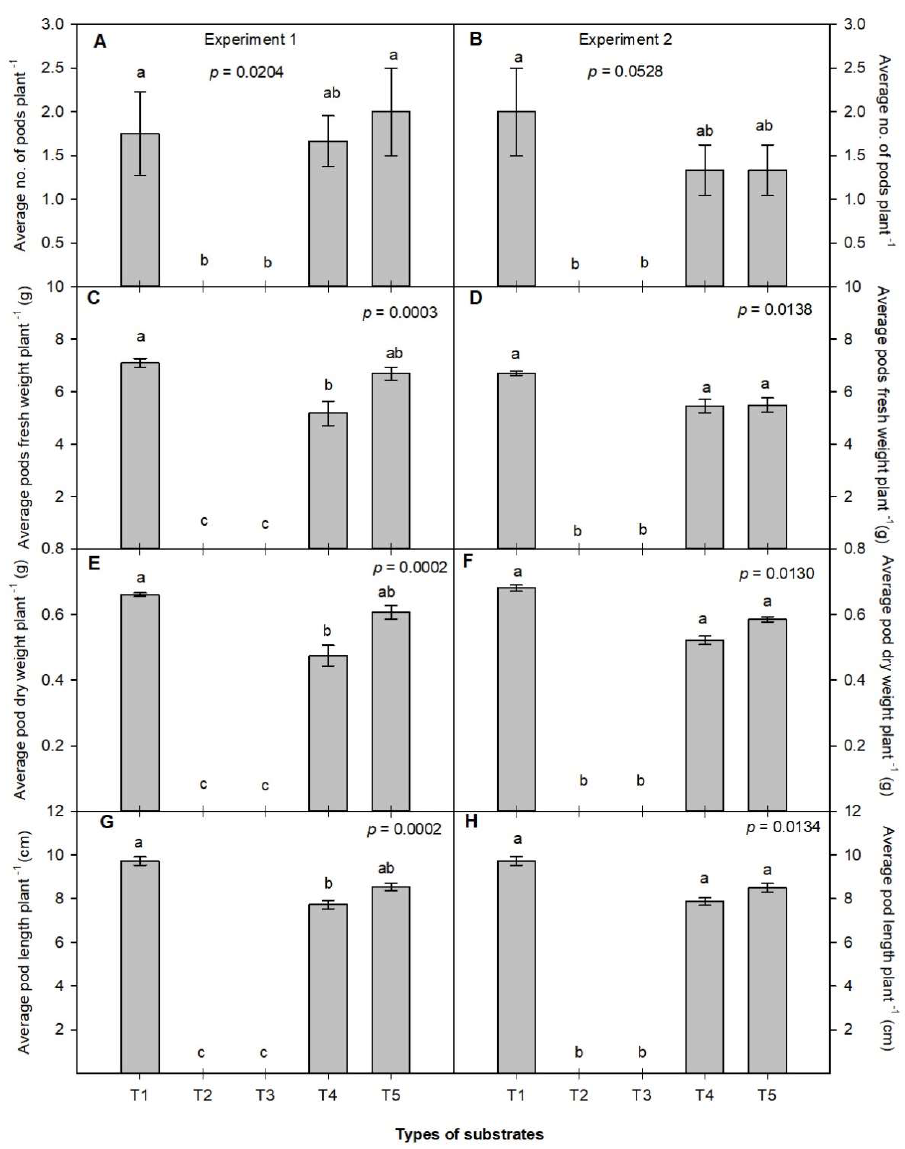
Figure 5. Effect of non-composted Bombax ceiba (Red cotton tree) sawdust mixtures on Abelmoschus esculentus L. (okra). The average number of pods plant −1 ( A , B ), average pods fresh weight plant −1 ( C , D ), average pods dry weight plant −1 ( E , F ), and average pods length plant −1 ( G , H ) in two independent experiments. All treatments (T 1 , T 2 , T 3 , T 4 , T 5 ) were the same as described in Figure 1. Different letters display significant differences between treatment mean values at the top of the vertical bars, as determined by the least significant difference test (LSD) at p < 0.05. Differences between treatments were very significant, as evidenced by the p = 0.0000. The error bars show the standard error ( n = 4). There was no pod development in T 2 and T 3 before